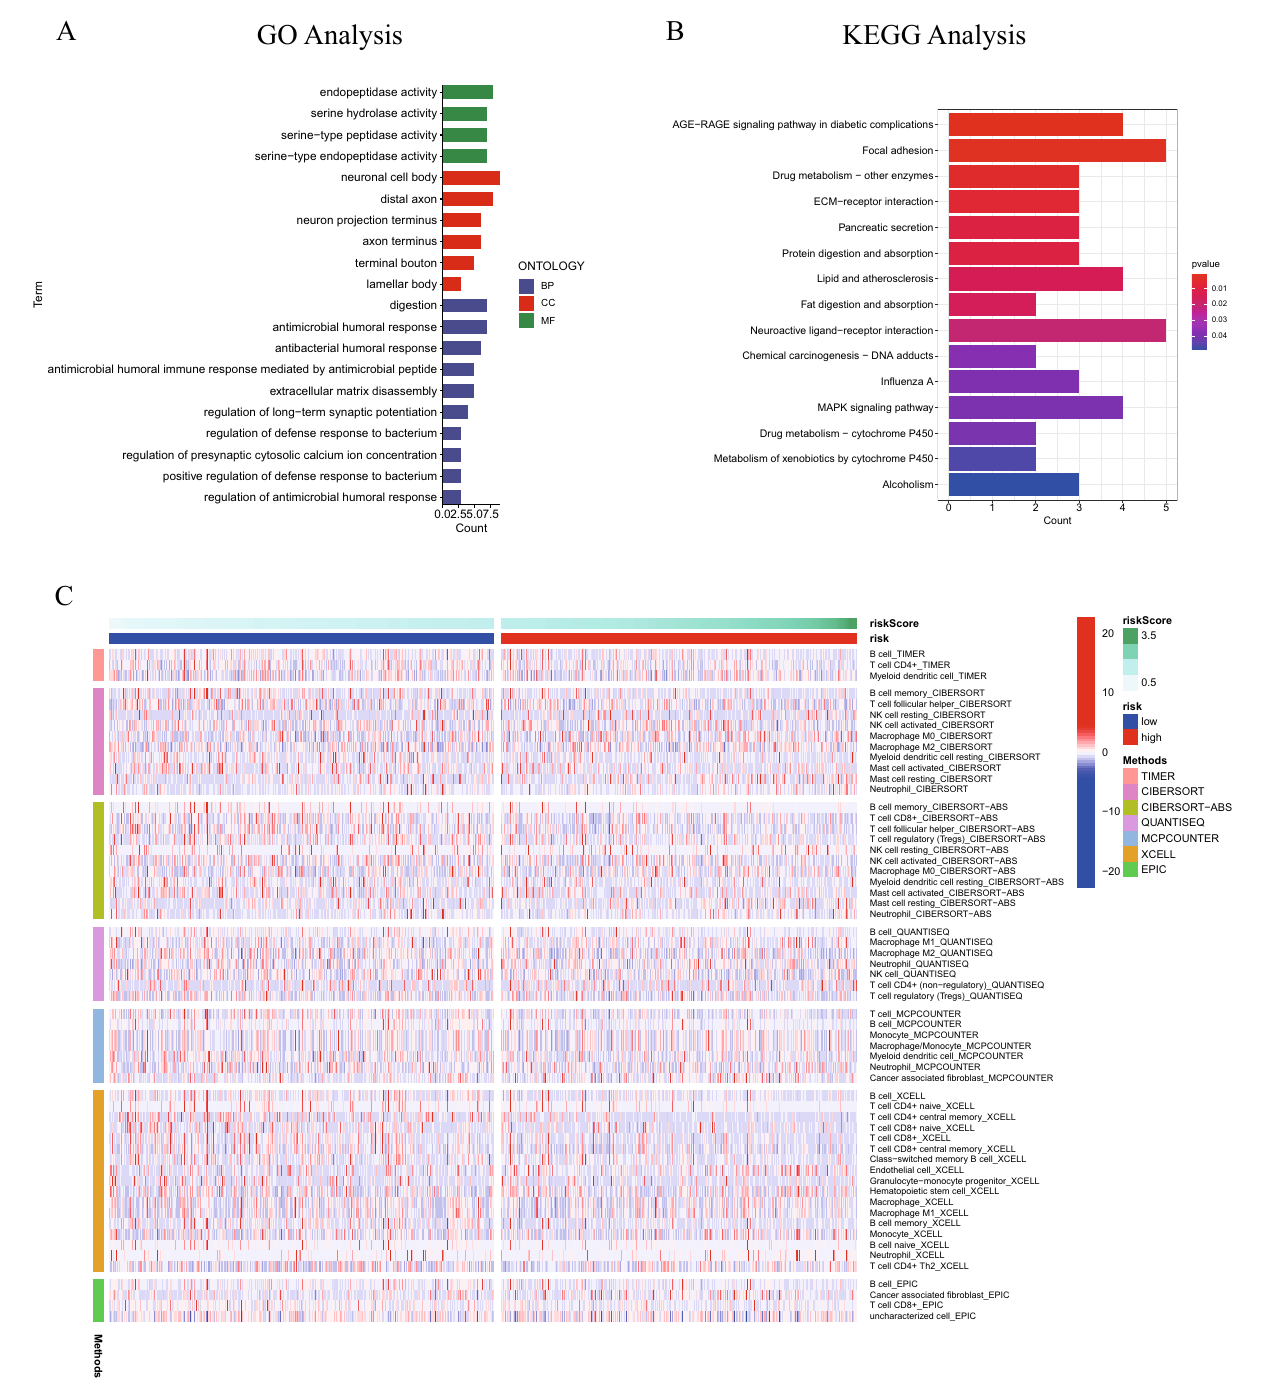
Figure 7. GO enrichment analysis ( A ) and KEGG enrichment analysis ( B ) of differently expressed genes between the high- and low- risk patients. ( C ) Heatmap of differently infiltrated immune cells between high- and low-risk patients according to the TIMER, CIBERSORT, CIBERSORT-ABS, QUANTISEQ, MCP-counter, XCELL and EPIC algorithms. GO, Gene Ontology; KEGG, Kyoto Encyclopedia of Genes and